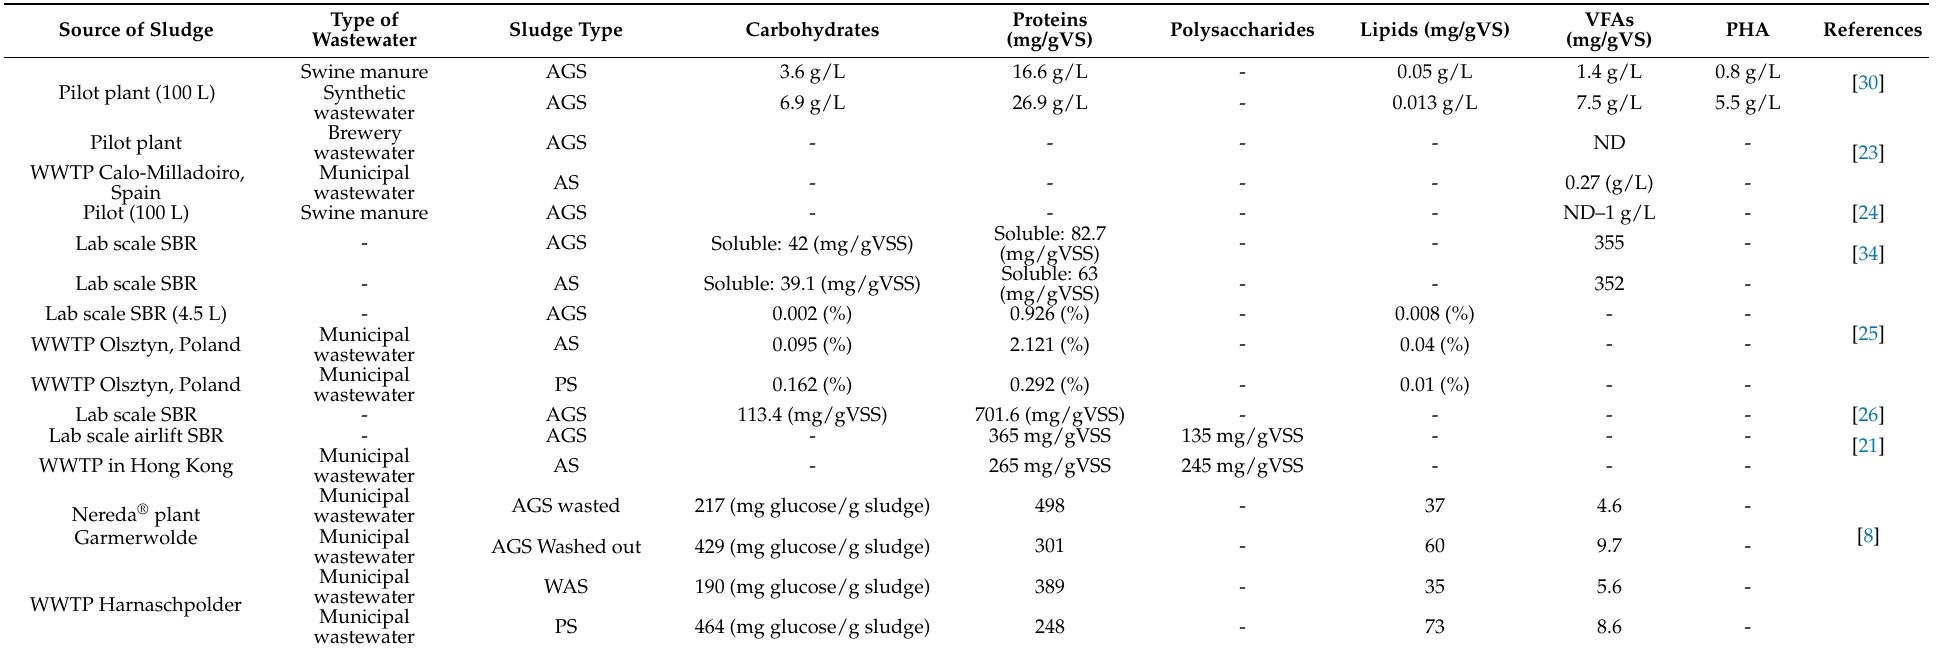
Table 3. Organic biopolymers composition of AGS and AS from different